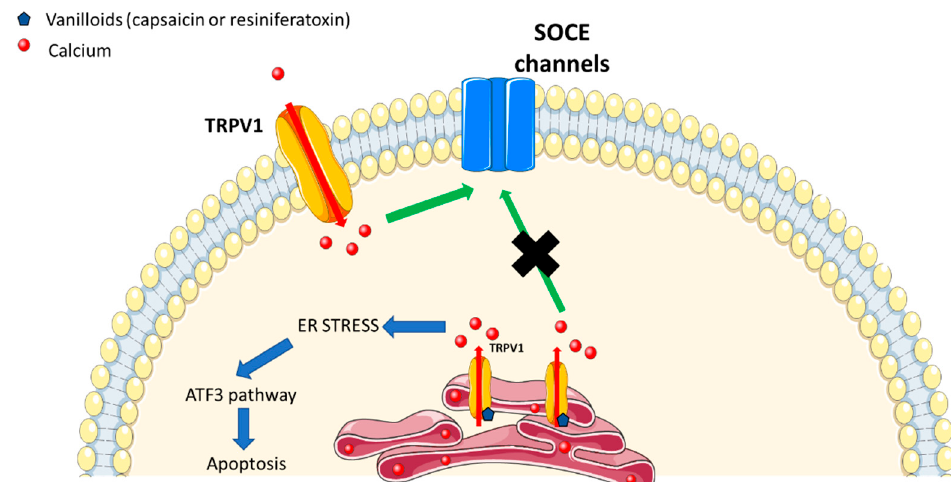
Figure 1. Endoplasmic reticulum-localized transient receptor potential vanilloid 1 (TRPV1) plays a different role than the plasma membrane-localized TRPV1 and can activate other calcium pathways.